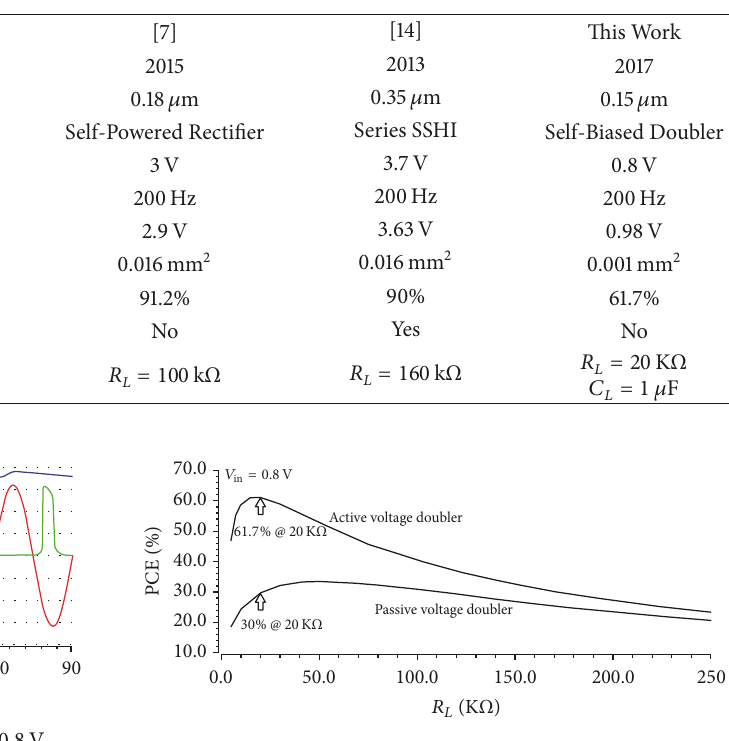
Figure 9: PCE as a function of load resistor ( 𝑅 𝐿